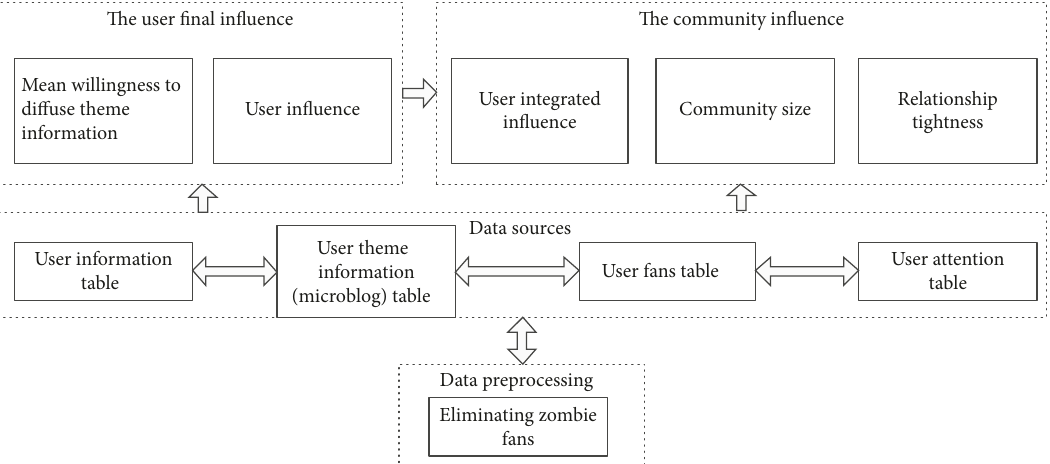
Figure 1: The framework of the proposed model.